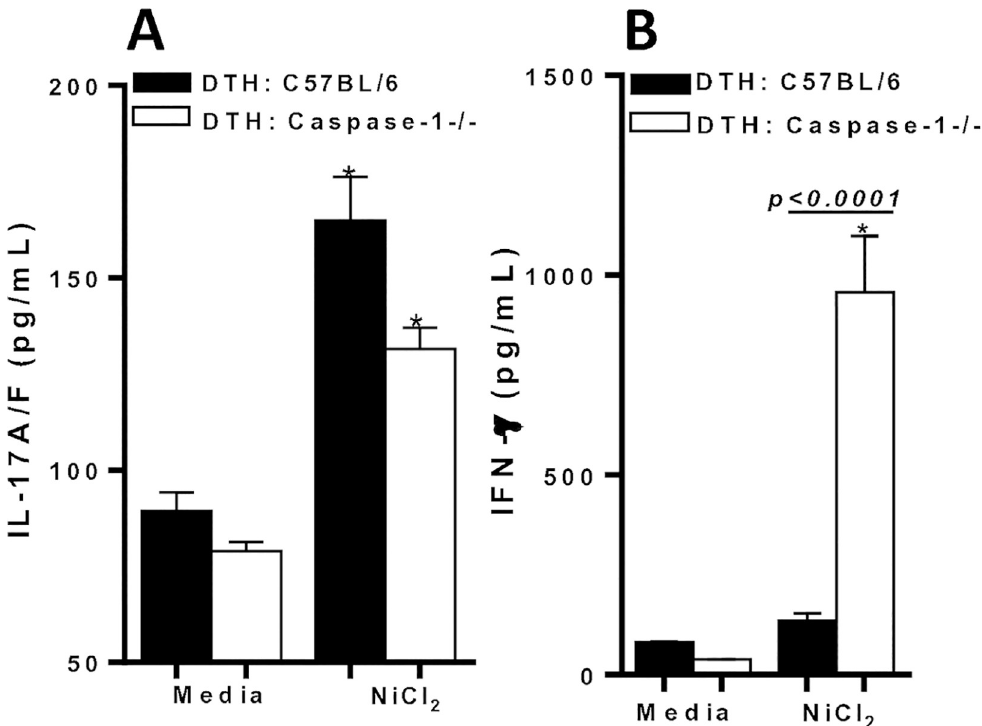
Fig 5. Cytokine production by CD4+ T cells from metal-DTH C57BL/6 and Caspase-1-/- mice. At D 14, spleens were harvested from metal-sensitized (DTH) C57BL/6 (black bars) and Caspase-1-/- (white bars) mice. CD4+ T cells were purified from mouse spleens and co-cultured with mitomycin-C treated na ï ve total spleen cells from either C57BL/6 or Caspase-1-/- mice respectively, with or without Ni (0.001mM) challenge for four days. Supernatants were harvested and assayed by ELISA for (A) IL-17A/F and (B) IFN- γ . Data represent one of three independent experiments with four mice/ group in each experiment. Data are shown as mean ± SEM. Statistical significance was determined by Student’s unpaired two-tailed t-test and asterisk ( � ) denote significant differences P �